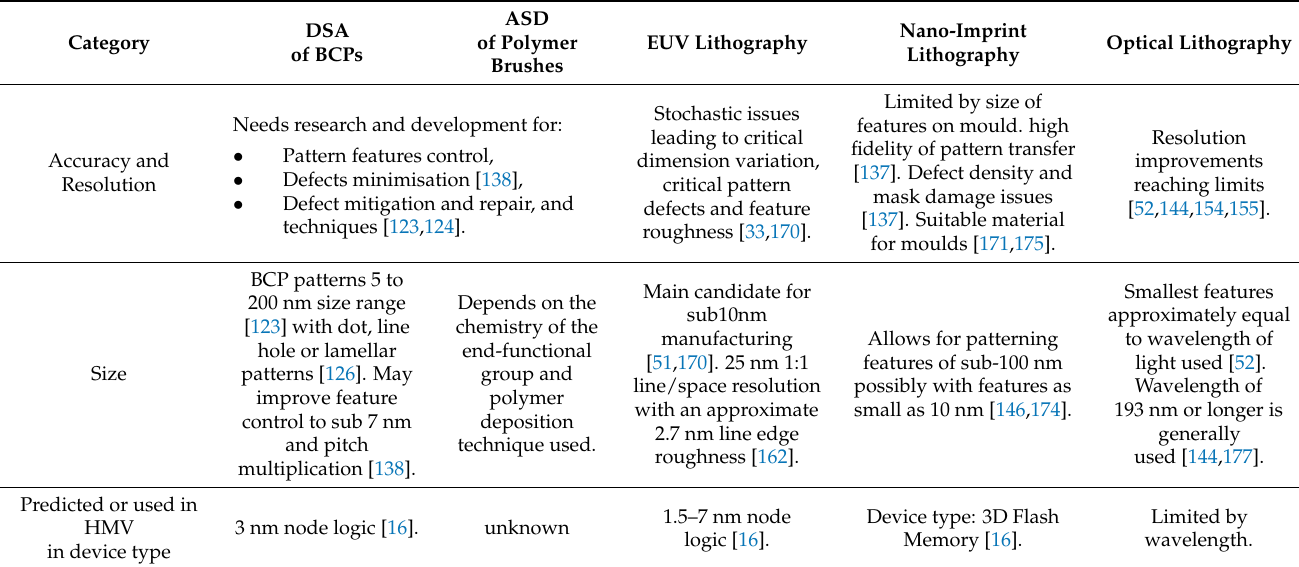
Table 2. Comparison of size and resolution of resulting nanofabricated